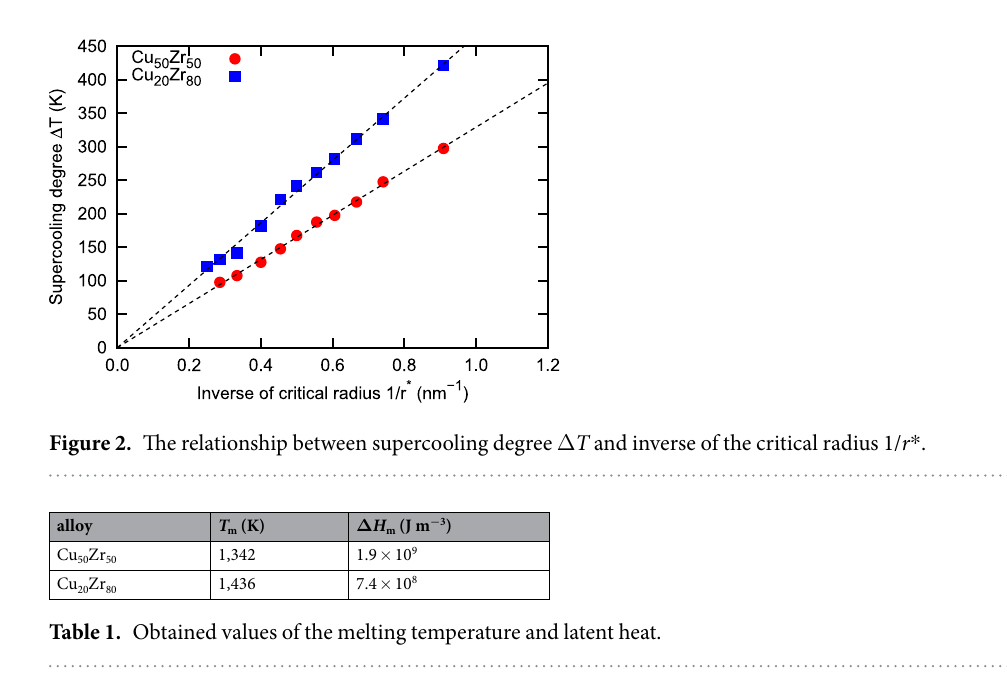
temperature. Although the melting temperature determined using biphase model can depend on interfacial crys- tal orientation, both are in reasonable agreement with each other as shown in Fig. S2(a). The free energy barrier of crystal nucleation Δ G * is computed using Eq. (16). The interfacial free energy σ is computed using Eqs. (14) and (15). The latent heat per unit volume Δ H m in Eq. (15) is evaluated from the enthalpy difference between the melt and crystal parts in the melt-crystal biphase model (Fig. S3). The melt and crystal models used in the biphase model are obtained by annealing the melt for 100 ps at 2,500 K and relaxing the crystal structure for 100 ps at 0.1 K under a zero pressure condition, respectively. The two structures are sub- sequently attached as shown in Fig. S3, and 600 ps MD relaxation is performed at the melting temperature T m and zero pressure condition. The computed Δ H m values are shown in Table 1. The findings reveal that Δ H m of Cu 50 Zr 50 is almost twice that of Cu 20 Zr 80 . The temperature dependent enthalpy is obtained by averaging the total energy over a 1 ns NPT ensemble MD simulation using a N = 16,000 atoms simulation cell with PBC at different temperatures ranging from 50 K to T m with 50 K intervals and a zero pressure condition. The obtained tempera- ture dependent enthalpies of the melt and crystal are fitted by the following quadratic polynomial function (see Fig. S4):